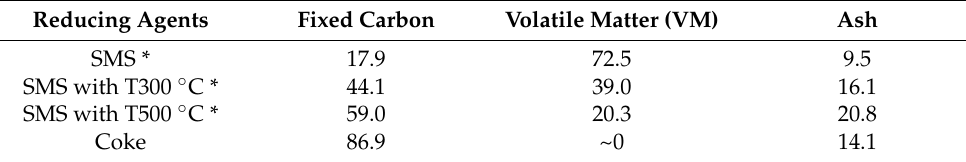
Table 1. Results of approximate analysis for SMS (mass %).